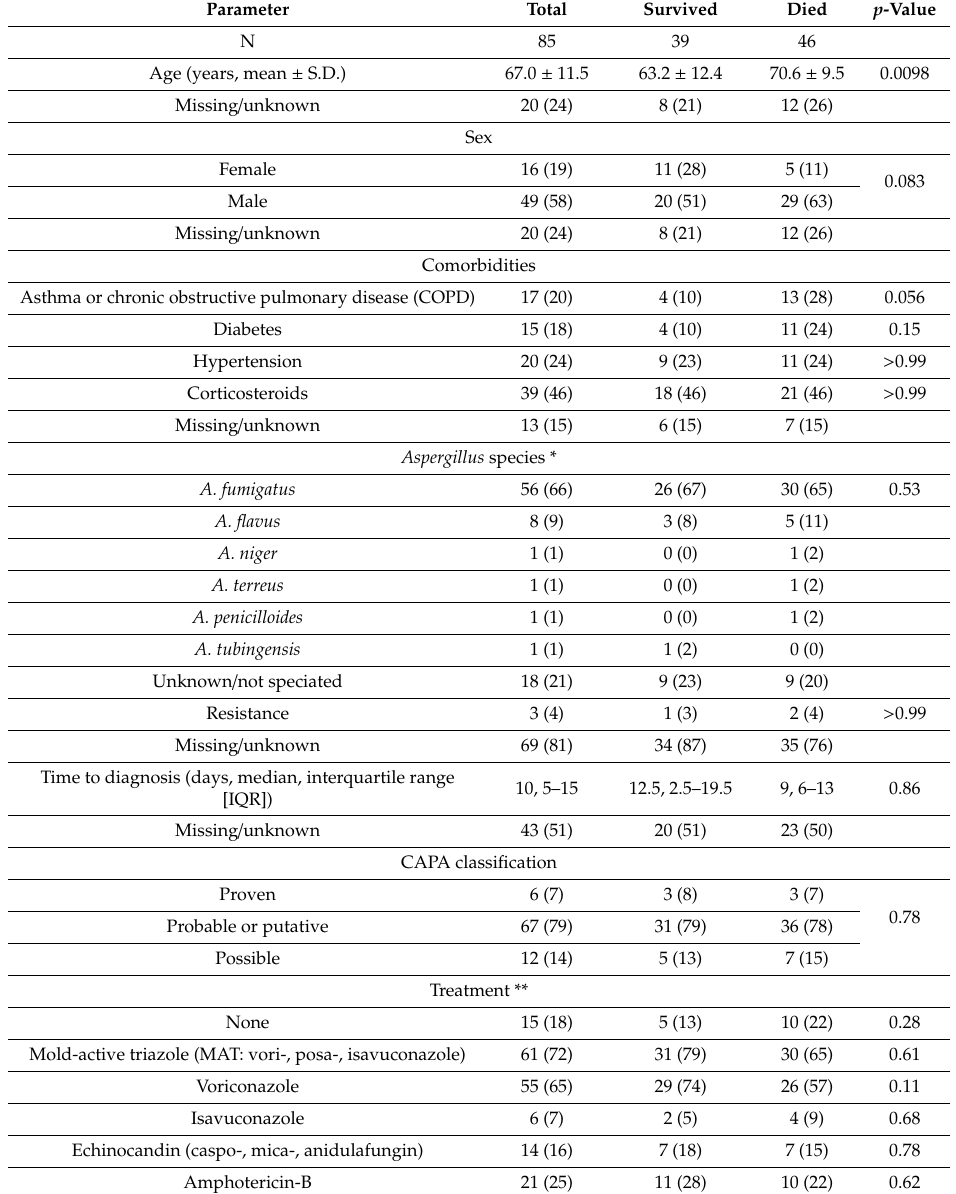
Table 1. Clinical characteristics, treatment and outcomes in patients with COVID-19-associated pulmonary aspergillosis (CAPA) who survived or died. Data are presented as N (%), unless otherwise